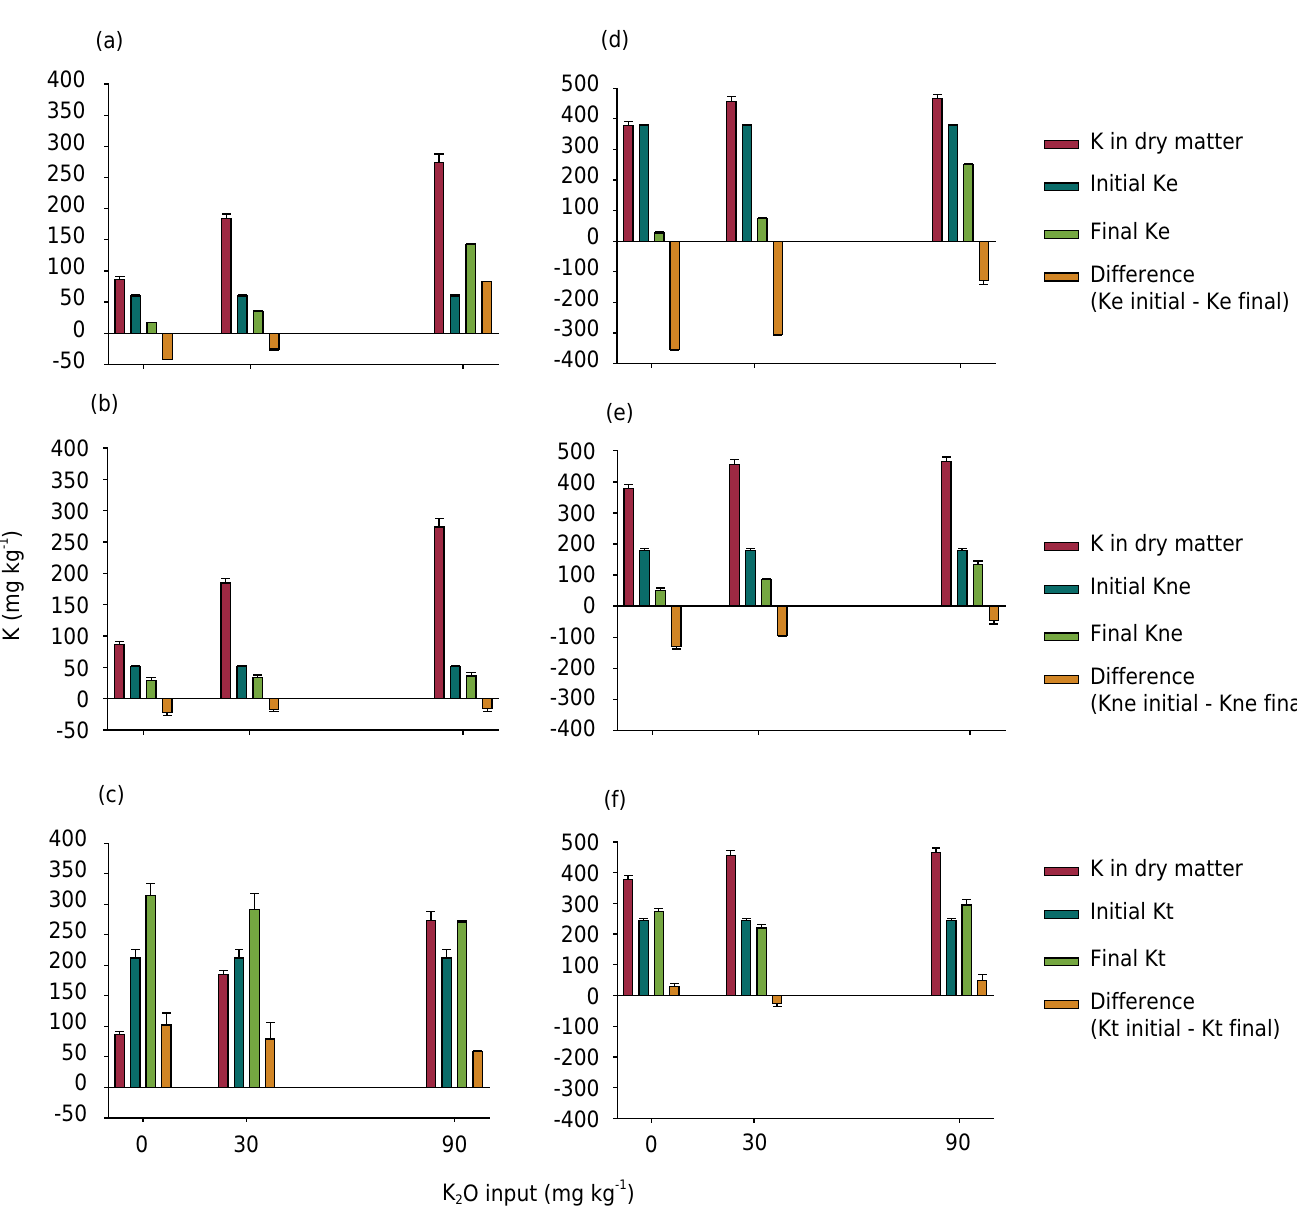
Figure 4. Potassium in plant dry matter. The initial K and final K contents were determined using different chemical extractors in an greenhouse experiment of a Ferralsol from Paraná, Brazil. (a) F60 - exchangeable K (Ke); (b) F60 - non-exchangeable K (Kne); (c) F60 - structural K (Ks); (d) F380 - exchangeable K (Ke); (e) F380 - non-exchangeable K (Kne); and (f) F380 - structural K (Ks). The treatments F60 and F380 represent the soil condition before beginning the greenhouse experiment; the K difference (Ke = exchangeable K; Kne = non-exchangeable K; and Ks = structural K) were determined by K content at the beginning experiment minus the K content at the end of the experiment for all K forms. The bars represent the Least Significant Difference (LSD) at